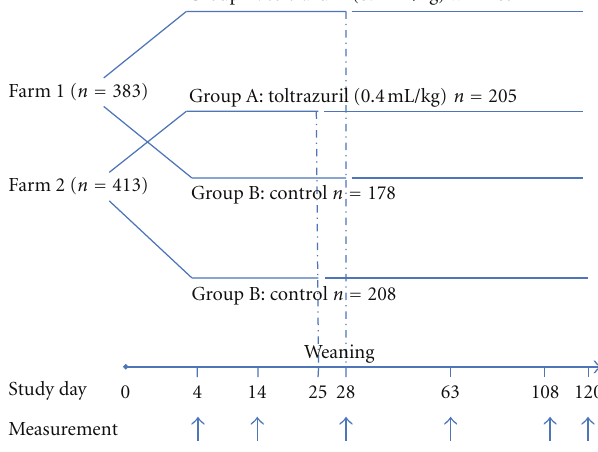
Figure 1: Experiment 1: Study design.